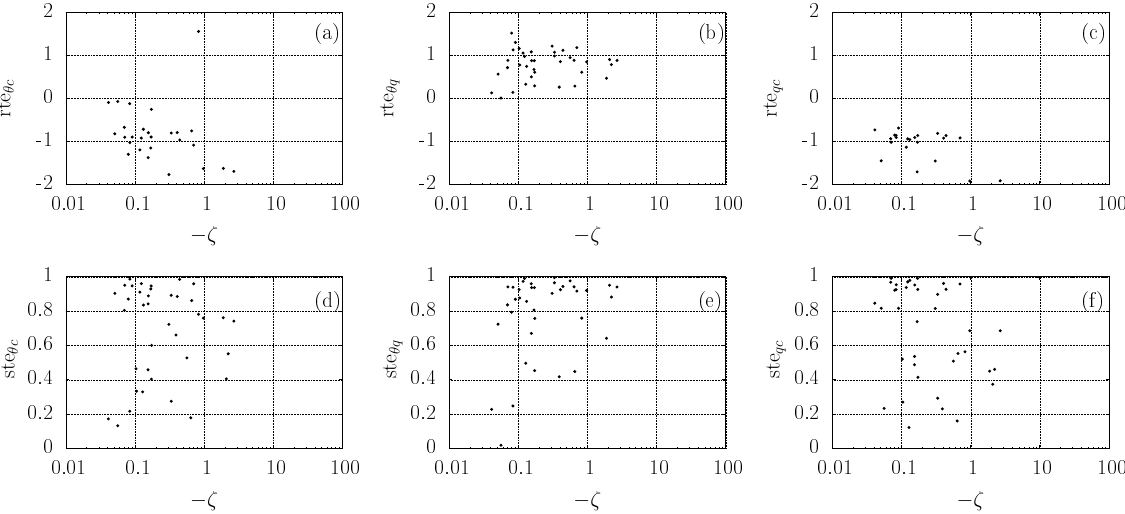
Figure 9. Scalar flux similarity indices rte (above) and ste (below) for 60 ◦ < | Z |≤ 90 ◦ : θ – c (a, d) ; θ – q (b, e) ; and q – c (c, f) . For rte, some data points were off the